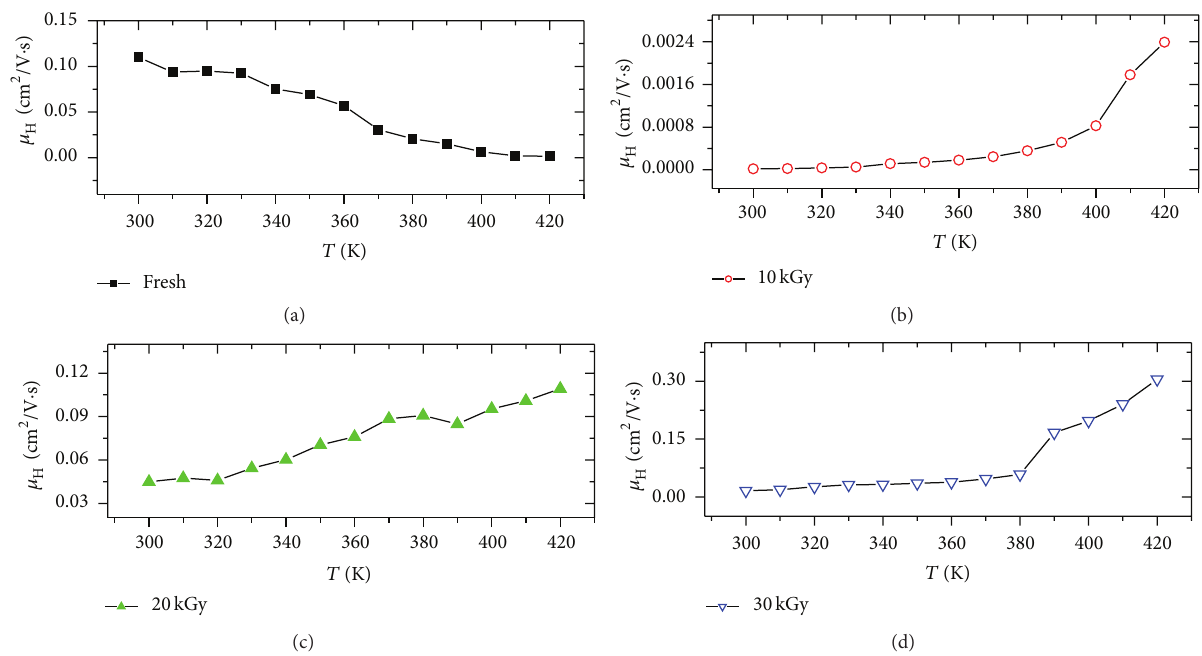
Figure 4: Temperature dependence of Hall mobility, 𝜇 different